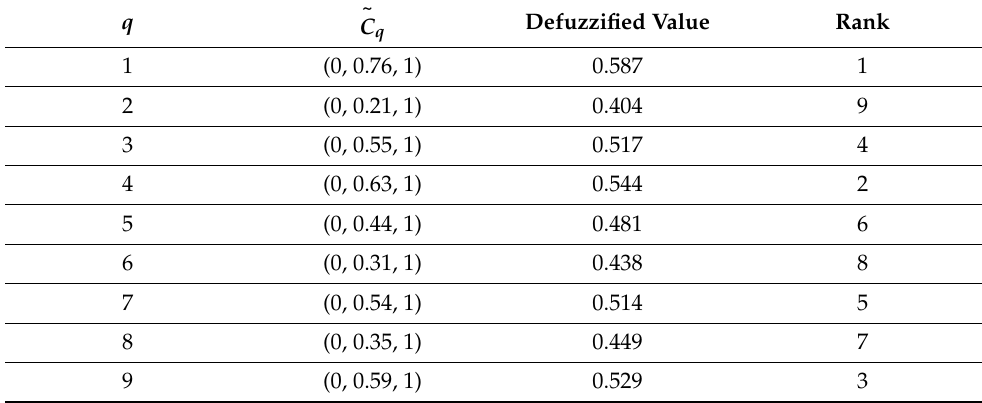
Table 7. Overall performances of smart technology